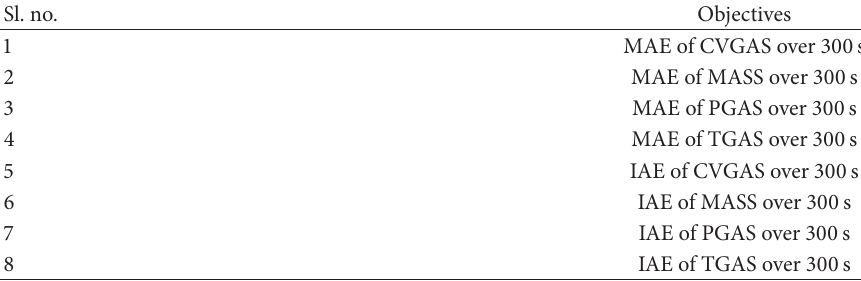
Table 4: MOPSO tuning objectives.